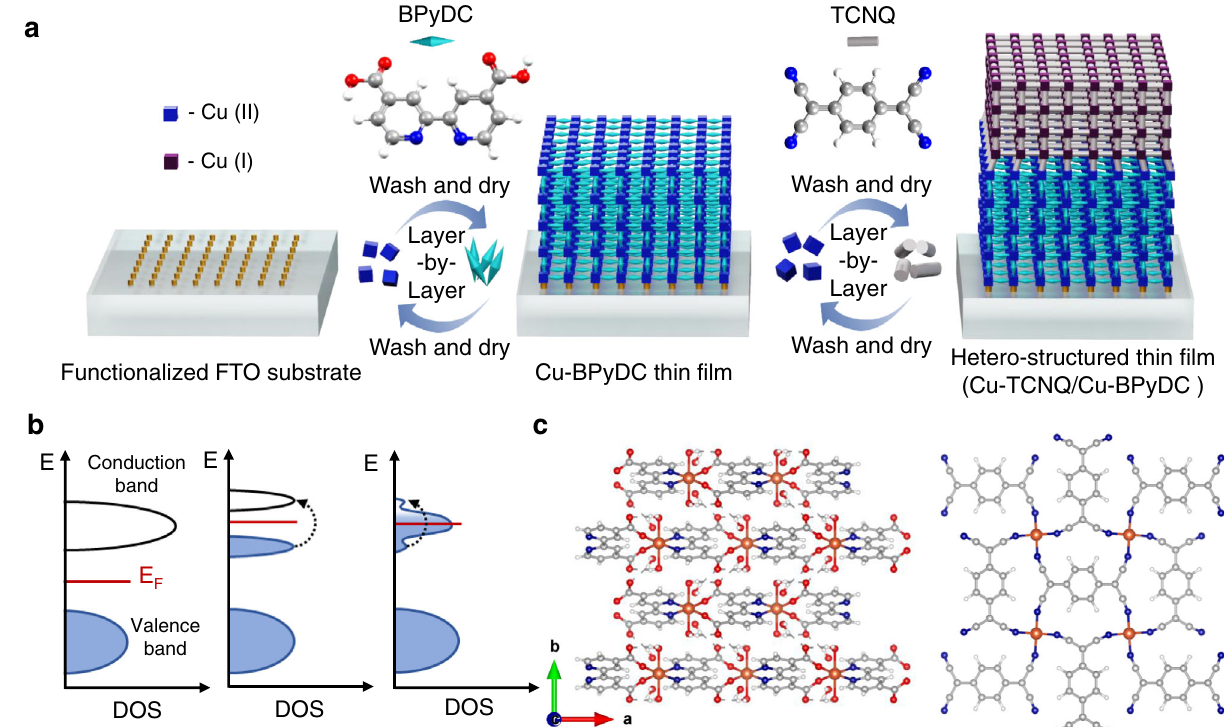
Fig. 1 | Schematics of the growth of hetero-structured thin fi lm of electrically insulatingMOFs.a Layer-by-layer(LbL)growthofCu-TCNQthin fi lmontopofCu- BPyDCthin fi lmviaIRRleadingtohetero-structuredCu(I)-TCNQ/Cu(II)-BPyDCthin fi lm. b Band diagram schemes of a band insulator (left), a Mott insulator (middle),